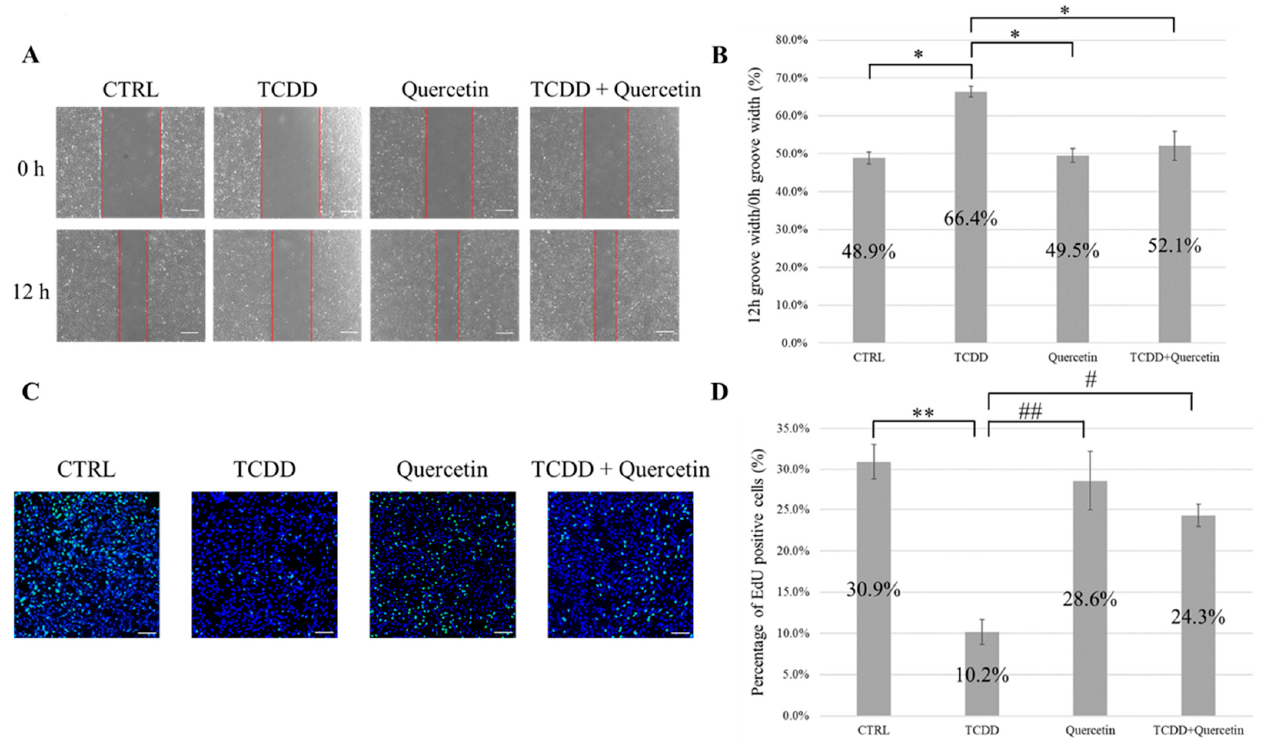
Figure 2. ( A ) Evaluation of the cell migration ability of mouse embryonic palatal mesenchymal (MEPM) cells by scratch assay. The cells of CTRL, TCDD, Quercetin, and TCDD + Quercetin groups were photographed immediately after scratching (0 h) and after 12 h of incubation (12 h). Scale bars = 500 μ m. ( B ) The ratio of the width of the 12 h groove to the width of the 0 h groove for each group was determined. * p < 0.05; ** p < 0.01. ( C ) Evaluation of cell proliferative ability of MEPM cells as assessed by EdU staining. Blue: Hoechst, Green: EdU. Scale bars = 100 μ m. ( D ) The percentage of EdU-positive cells in each group was determined. * p < 0.05; ** p < 0.01 vs. CTRL. # p < 0.05; ## p < 0.01 vs. TCDD.